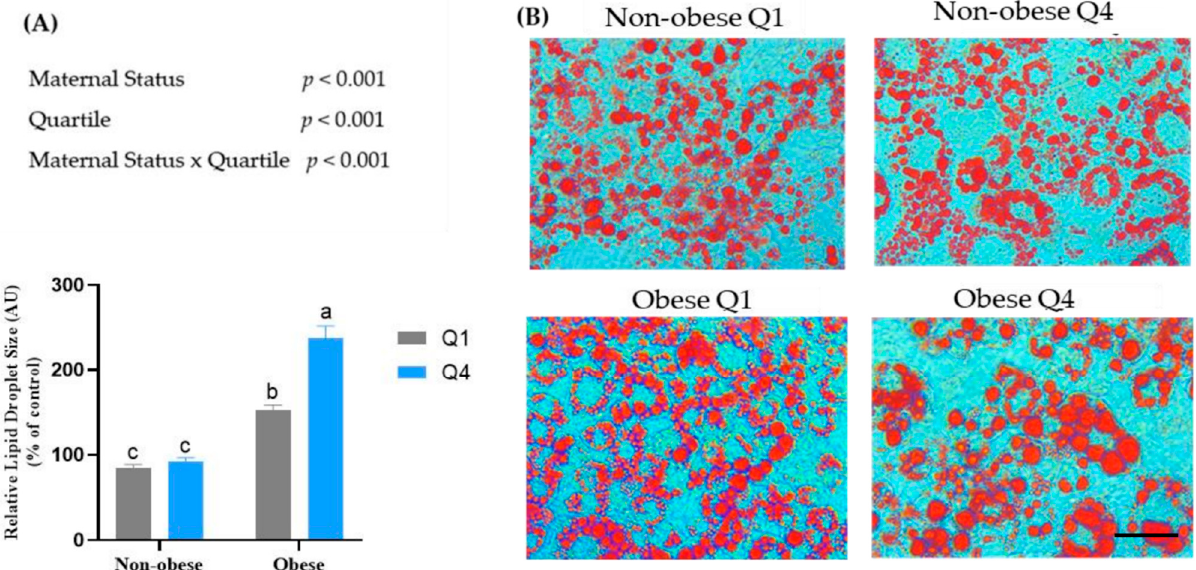
Figure 1. Effects of breast milk on lipid accumulation in 3T3-L1 adipocytes. Preadipocytes were differentiated for eight days in the presence or absence of breast milk (BM) whey, and oil red O staining was performed on day 8. Stained adipocytes were viewed using a Leica DMIL LED Tissue Culture Microscope, and images were taken using the Infinity Camera Analyze Software at 400× magnification. Scale bar = 50 μ m ( A ) Relative lipid droplet size analyzed using the ImageJ software. Values are expressed as mean ± SD, n = 3, different superscripts (a, b, c) are used to denote significant differences between the treatment groups, p < 0.05 was considered significant ( B ) Representative images of the cells stained with oil red O. Q—quartile. 3.4. Maternal BMI and BM n-6:n-3 PUFA Ratio Alters the mRNA Expression of Lipogenic Genes The initial step of lipogenesis involves the conversion of acetyl-CoA to malonyl-CoA by Acc1 , which is the rate-limiting step in de novo fatty acid synthesis. The mRNA Expres- sion of Acc1 was higher in the cells treated with BMNO compared to the cells treated with BMO (+68% increase; p < 0.01; Figure 2A). There was a significant interaction between maternal BMI status and quartile (interaction, p < 0.05). Cells treated with BMNO Q4 had a higher mRNA expression of Acc1 compared to cells treated with BMNO (Q1). Further- more, BMNO Q4-treated cells had a higher mRNA expression of Acc1 compared to BMO Q4-treated cells. There was no change in Acc1 mRNA expression in BMO Q1- and BMO Q4-treated cells. Malonyl-CoA synthesized by Acc1 is converted to palmitate (C16:0) by Fasn . There was a significant effect of maternal BMI status on the mRNA expression of Fasn ; cells treated with BMNO had a higher expression compared to the cells treated with BMO ( p < 0.01; Figure 2B). There was also a significant interaction between maternal status and quartile (interaction p < 0.05). There was no significant difference in Fasn mRNA expres- sion between cells treated with Q4 BMNO vs. Q1 BMNO and BMO Q4 vs. BMO Q1. Synthesized palmitate and stearic acid (C18:0) undergo desaturation by Scd1 activity to generate palmitoleic acid (C16:1) and oleic acid (C18:1), respectively. Oleic acid is con- sidered as the storage fatty acid. There was a significant difference in the mRNA expres- sion of Scd1 between cells treated with BMO and BMNO, revealing a higher expression in the cells treated with BMNO compared to the cells treated with BMO ( p < 0.01; Figure 2C). Furthermore, there was a significant interaction between maternal BMI status and quartile (interaction, p < 0.05). Cells treated with Q4 BMNO had a higher mRNA expression of Scd1 compared to cells treated with Q1 BMNO (+100%; p < 0.01, Figure 2C). There was no sig- nificant difference between BMO Q4- and BMO Q1-treated cells. Interestingly, there was